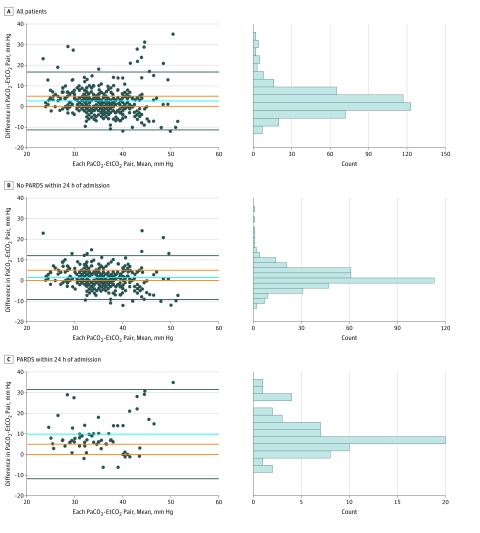
Bland-Altman Analysis Comparing Partial Pressure of Carbon Dioxide, Arterial (Paco2) and End-Tidal Carbon Dioxide (EtCO2)A, Bland-Altman analysis comparing Paco2 and EtCO2 for all patients (445 Paco2-EtCO2 pairs for 137 patients; 187 [42.0%] of these pairs had EtCO2 values within 5 mm Hg of paired Paco2). B, Bland-Altman analysis comparing Paco2 and EtCO2 for those who did not develop pediatric acute respiratory distress syndrome (PARDS) within 24 hours of pediatric intensive care unit (PICU) admission (376 Paco2-EtCO2 pairs for 123 patients; 176 [46.8%] of these pairs had EtCO2 values within 5 mm Hg of paired Paco2). C, Bland-Altman analysis comparing Paco2 and EtCO2 for those who developed PARDS within 24 hours of PICU admission (67 Paco2-EtCO2 pairs for 14 patients; 11 [16.4%] of these pairs had EtCO2 values within 5 mm Hg of paired Paco2). Bias is represented by the blue line. The limits of agreement are represented by the black lines and adjust for repeated measures. A priori limits of acceptable agreement are represented by orange lines. Marginal histograms describe distribution of values between pairs.